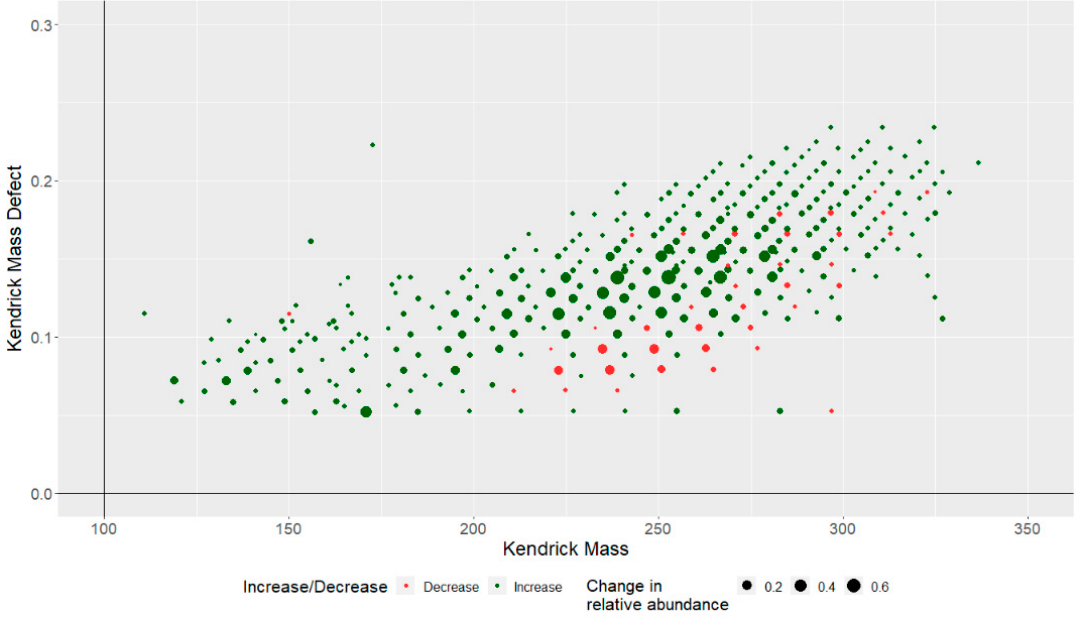
Figure 4. Kendrick mass plot of the relative abundance of NAFCs for all assigned formulas analyzed by negative-ion ESI-high-resolution Orbitrap-MS.